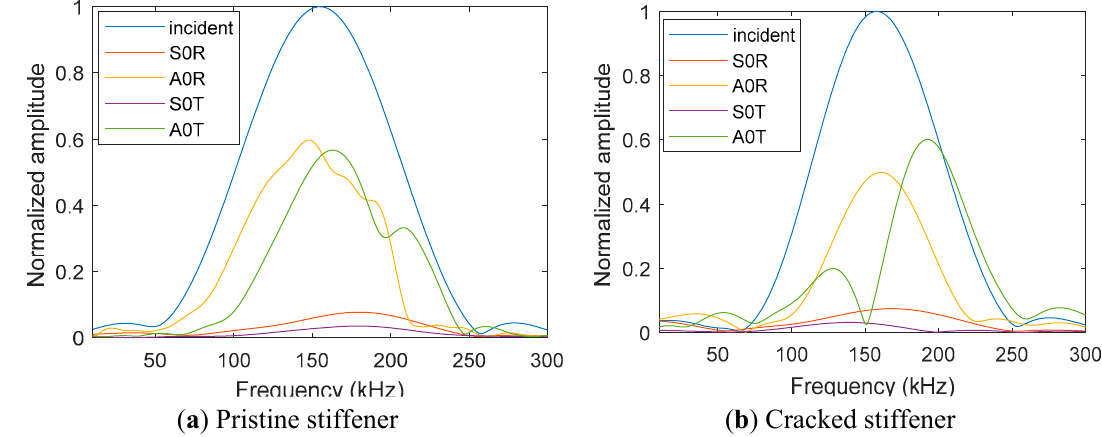
Figure 11. FFT of the incident and scattered Lamb waves: ( a ) pristine stiffener; ( b ) cracked stiffener.